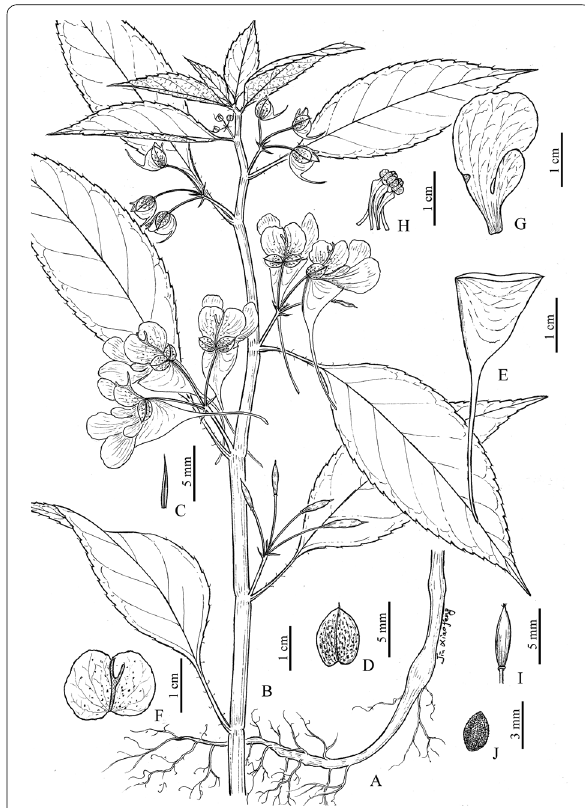
Fig. 4 Impatiens wuyiensis J.S.Wang, Y.F.Lu & X.F.Jin. a habit (showing lower part and roots); b habit (showing upper part); c bract; d lateral sepal; e lower sepal; f upper petal; g lateral petals; h stamens; i ovary; j seed (Drawn by X.F. Jin from the